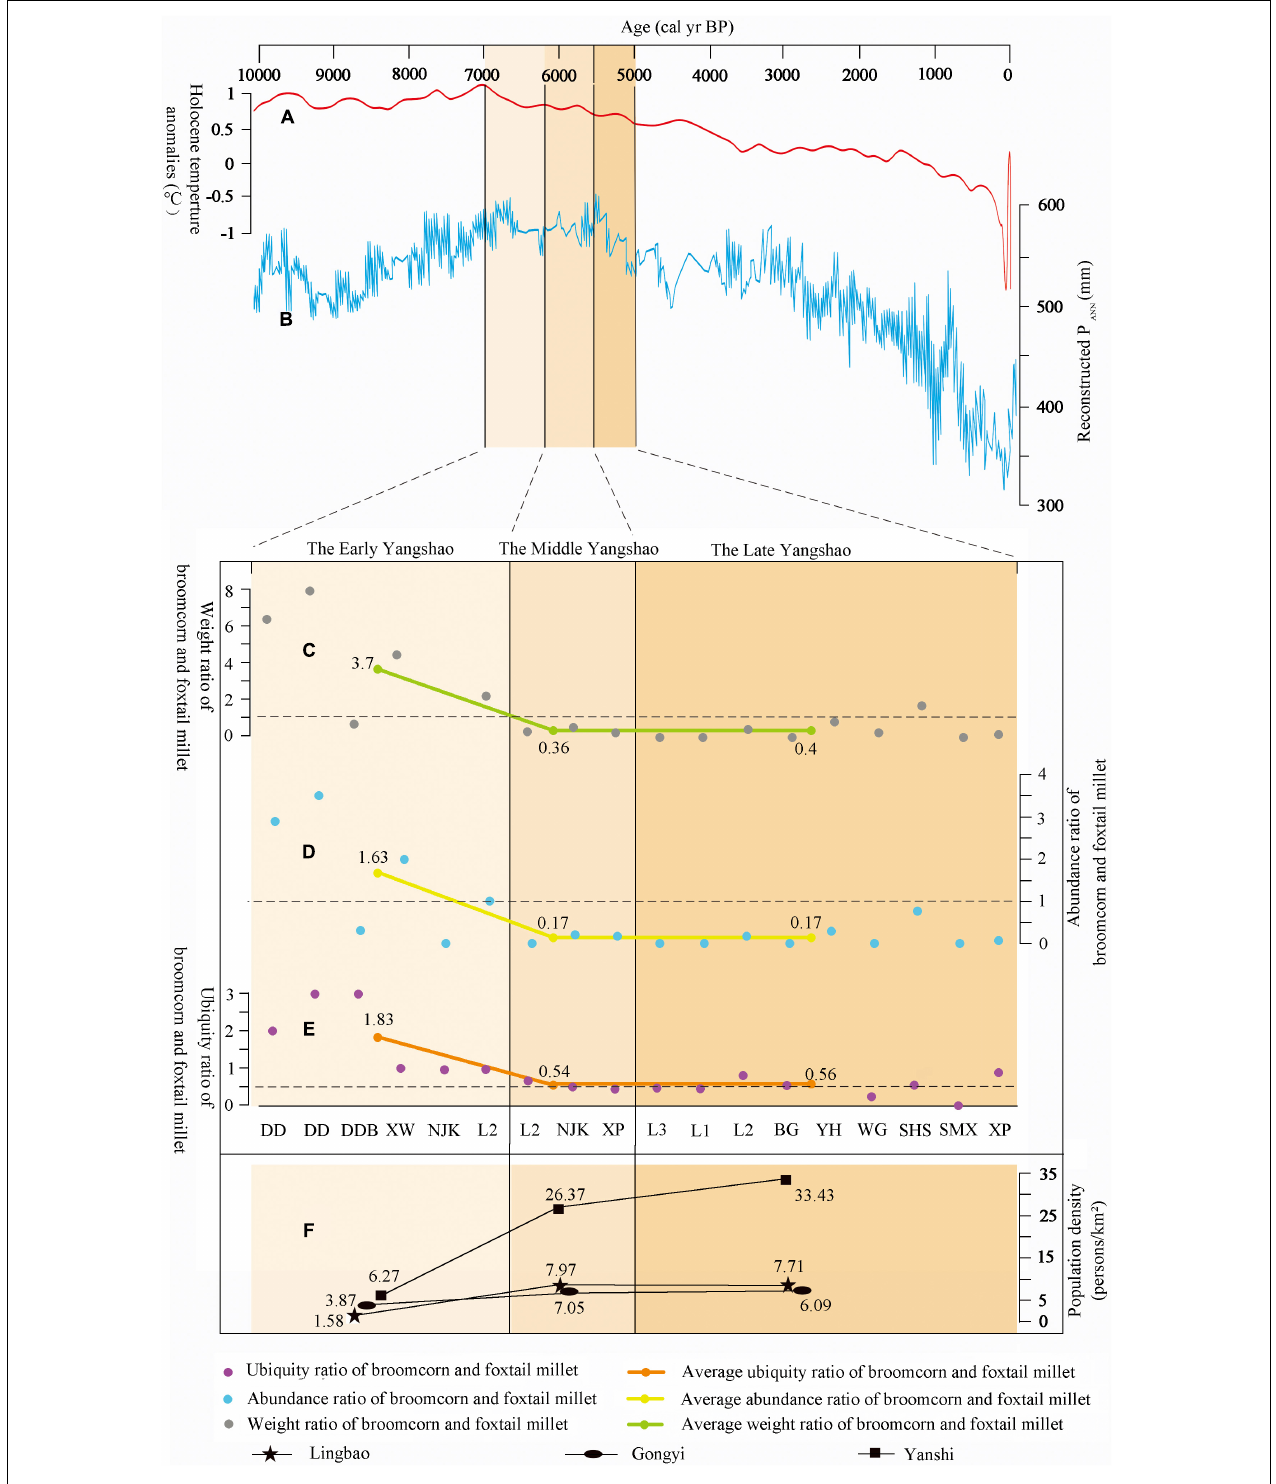
FIGURE 4 | Climate, three ratios of broomcorn millet to foxtail millet, population density curve. (A) Synthesized Northern Hemisphere (30 ◦ –90 ◦ N) temperature record during the Holocene55 (Shakun et al., 2012; Marcott et al., 2013). (B) Pollen-based annual precipitation (PANN) reconstructed from Gonghai Lake (Chen et al., 2015). (C) Weight ratio of broomcorn millet to foxtail millet from sites examined in this study. (D) Abundance ratio of broomcorn millet to foxtail millet from sites examined in this study. (E) Ubiquity ratio of broomcorn millet to foxtail millet from sites examined in this study. (F) Population density in central and western Henan Province (Wang J. H.,